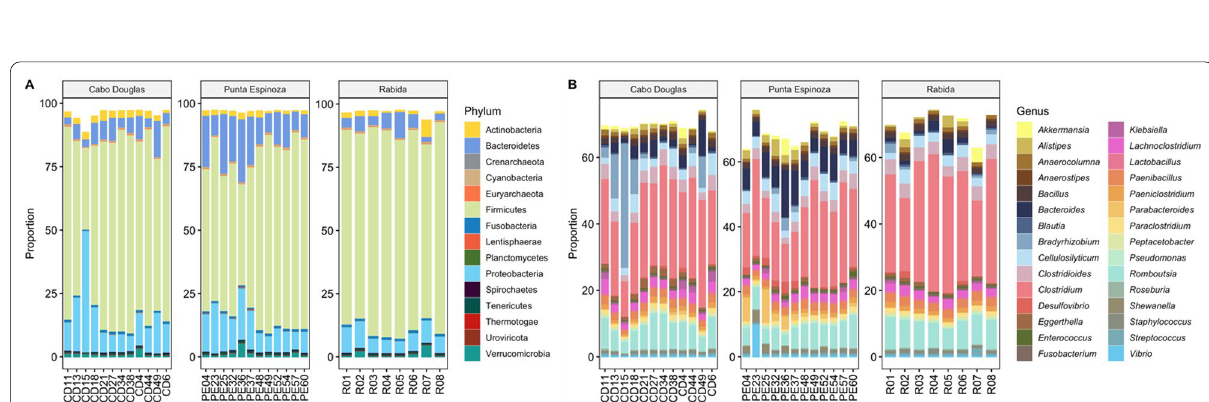
Fig. 3 Gut microbiome composition (shot-gun sequencing) of marine iguanas from Fernandina and Rabida Islands. A Bar plot showing the proportion of the top 15 phyla by location. B Bar plot showing the proportion of the top 30 most abundant genera by